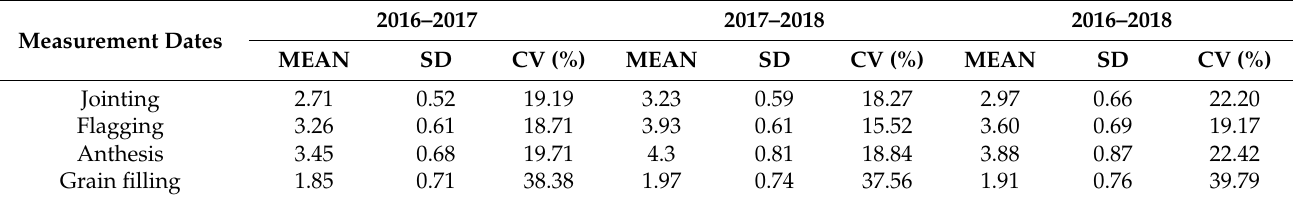
Table 3. Main statistical parameters of LAI from each growth stage in different growing